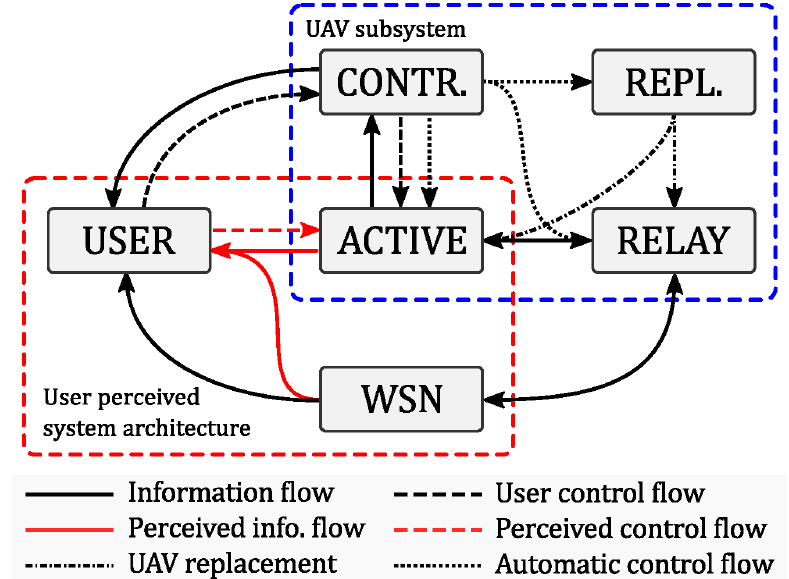
Figure 7. Architecture of the UAV